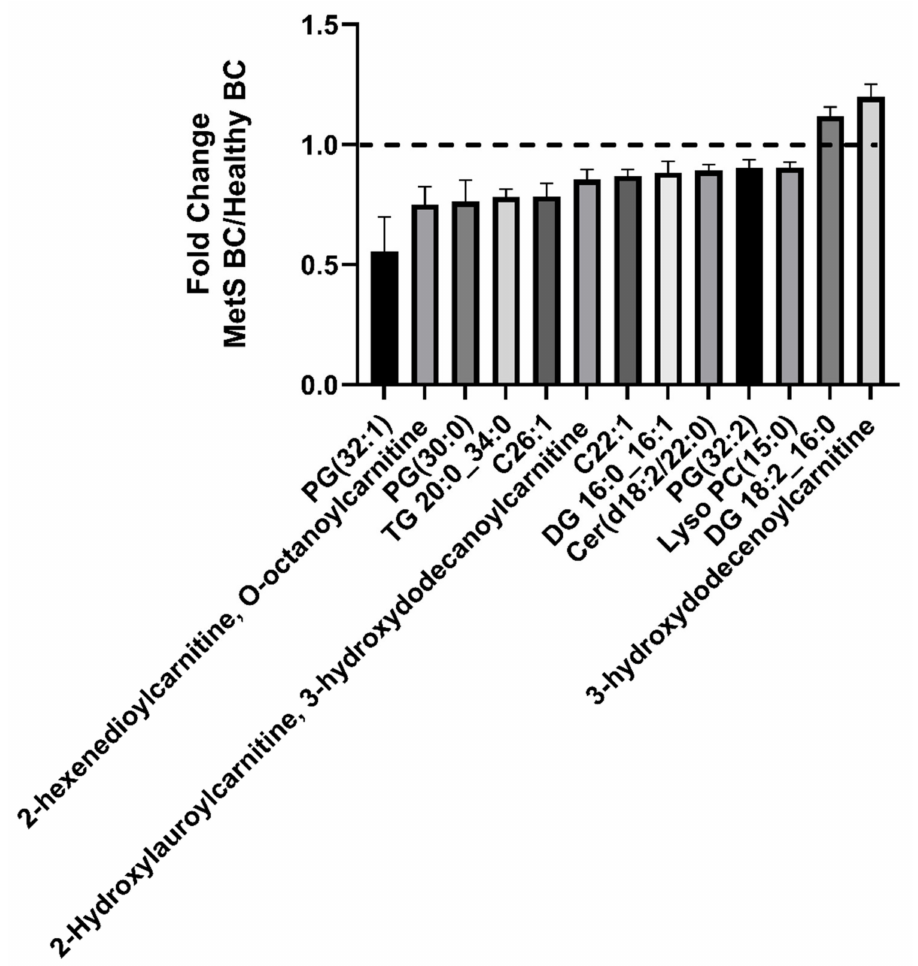
Figure 4. Fold change of selected lipids between the healthy and MetS BCs. Up/down regulation of selected lipids between each BCs are depicted as fold changes. Fold change was calculated based on the mean value of relative abundance of all samples from the same group. Values larger than 1 indicate the lipid was more abundant in MetS BC, while values less than 1 indicate that the lipid was more abundant in healthy BCs ( p < 0.05, n =